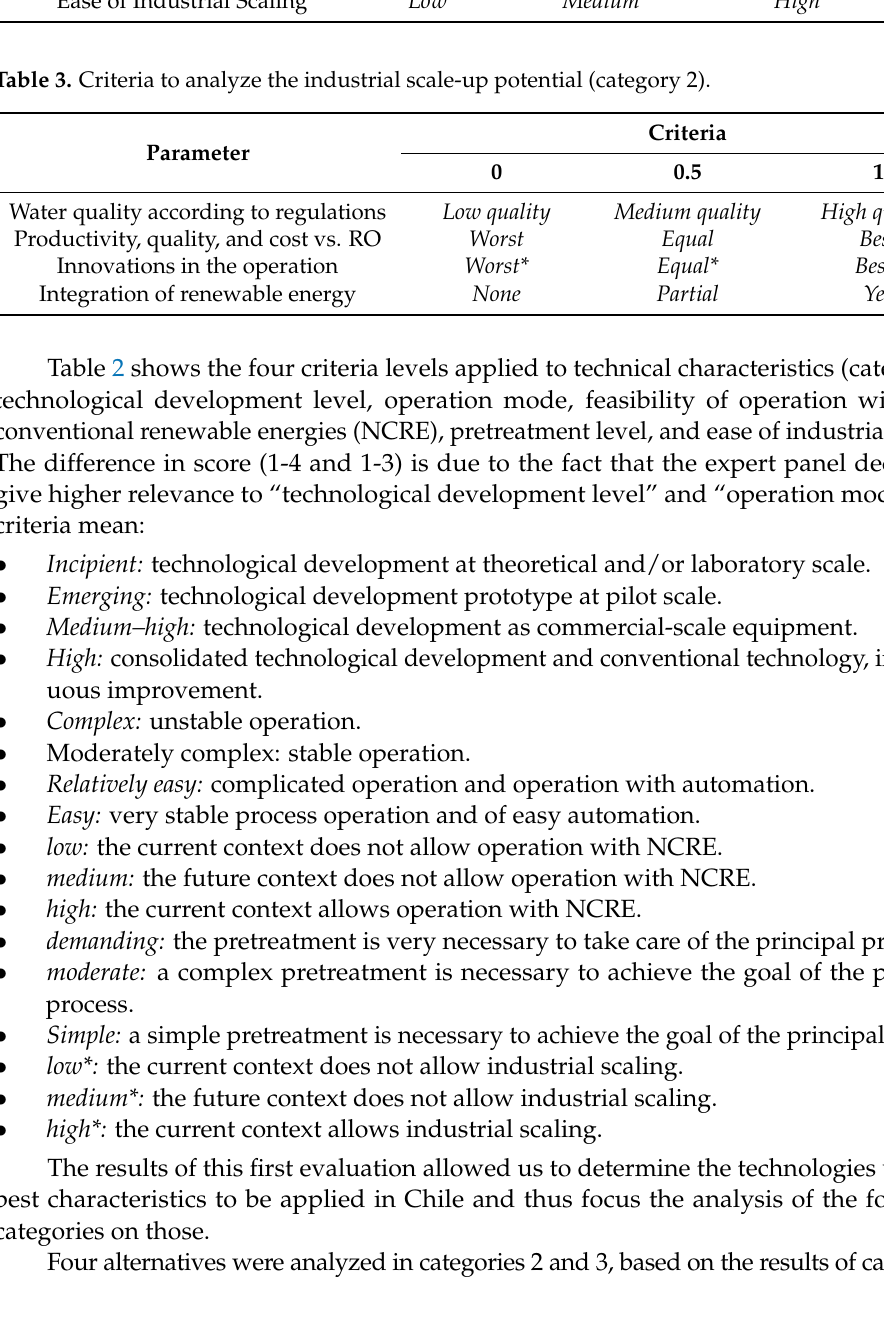
Table 2. Criteria to analyze the most relevant characteristics of conventional and emerging technologies. Criteria Characteristic 1 2 3 4 Technological Development Level Incipient Emerging Medium–high High Operation Mode Complex Moderately complex Relatively easy Easy Characteristic 1 2 3 Feasibility of Operation with NCRE low medium high Pretreatment Level demanding moderate simple Ease of Industrial Scaling Low* Medium* High*